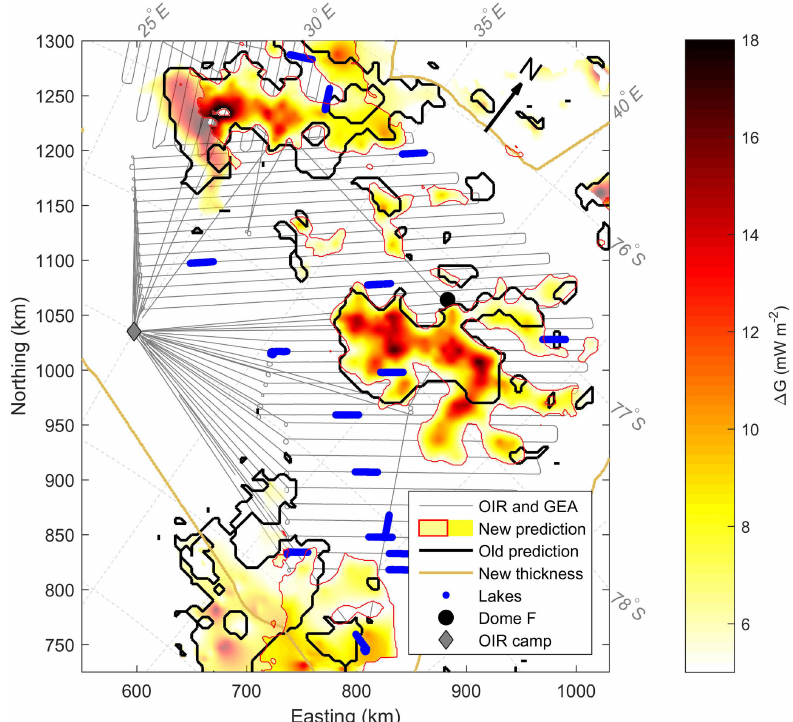
Figure 4. Updated predictions of possible Oldest Ice locations in colours, compared to the prediction of Van Liefferinge and Pattyn (2013), outlined in black. The colour scale show the values of (cid:49)G , semi-transparent colours show areas with a threshold horizontal ice-flow velocity of < 2ma − 1 , fully saturated colours show areas where the threshold is < 1ma − 1 . Blue dots show lake locations identified from the radar data, the extent of the gridded OIR thickness map is outlined with a yellow line, i.e. predictions outside the line are based on Bedmap2 values (cf. Fig.